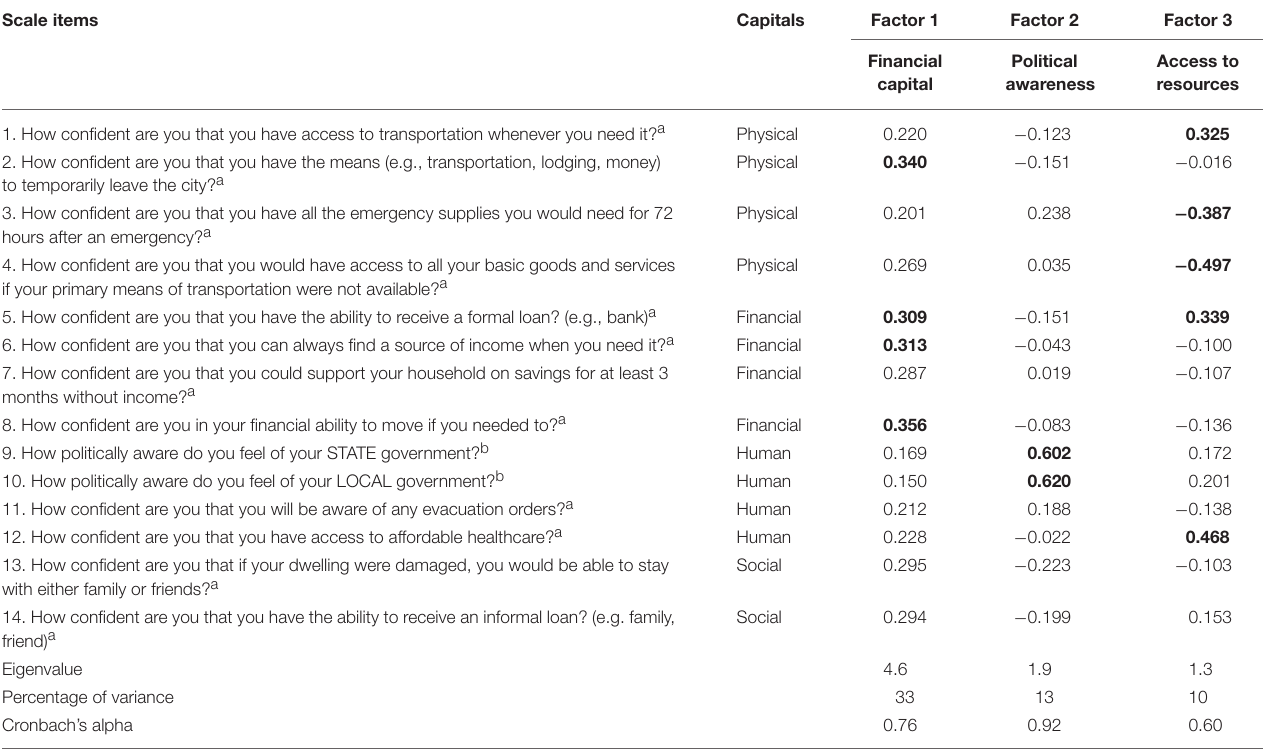
TABLE 2 | Principal components analysis of adaptive capacity scale items after removing scale items with low item-total correlations. Scale